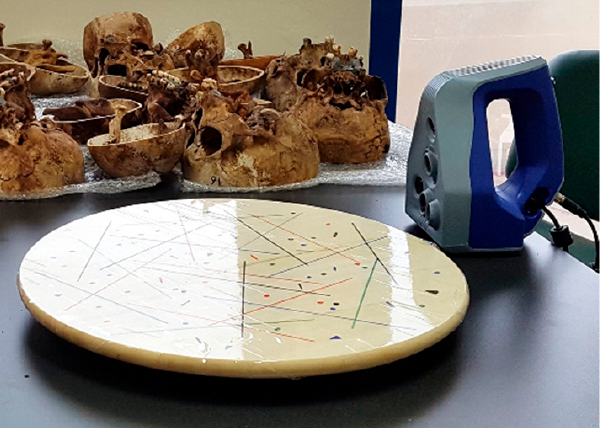
Figure 1. The Artec Space Spider scanner, the rotating table used to perform the scans and selected specimens.